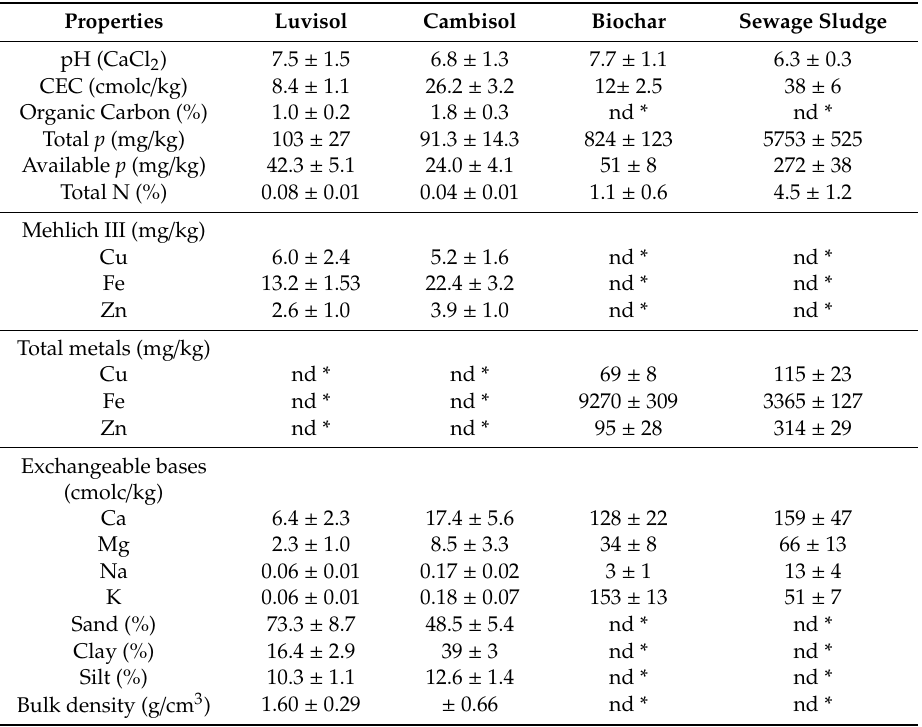
Table 2. Pre-crop planting soil properties and basic characteristics of sludge and biochar used in the study.